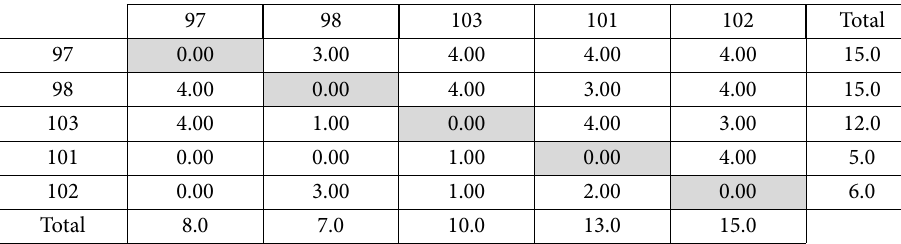
Table 6. Direct influence matrix for C4